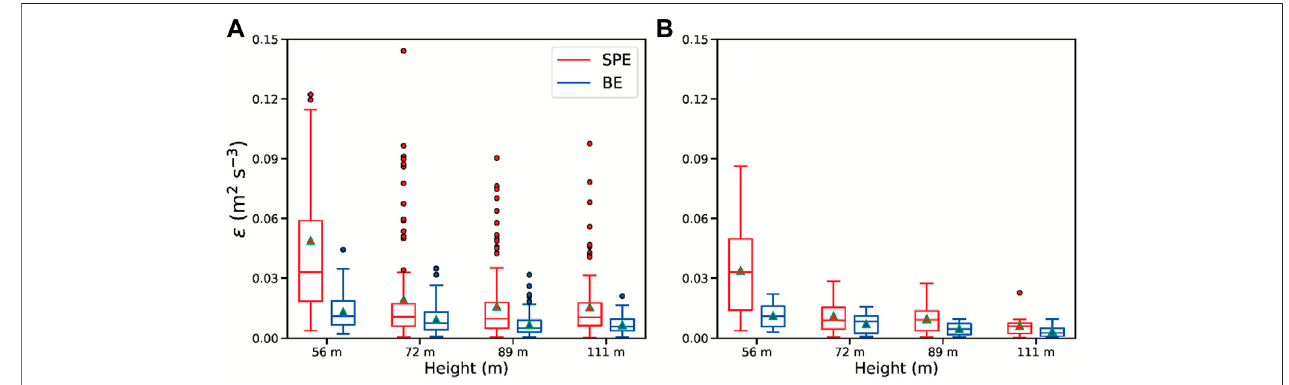
FIGURE 4 | Boxplots of the dissipative rates at the four observational levels using (A) all the good runs and (B) good runs coexisting at all the levels at a given time [withthelowerandupperquartilesasthelowerandupperlimitsofthebox,respectively;themedian(lineinthebox);themean(triangles),andoutliers(blackcircles)].Blue and red colors indicate the BE and turbulent spectra methods,